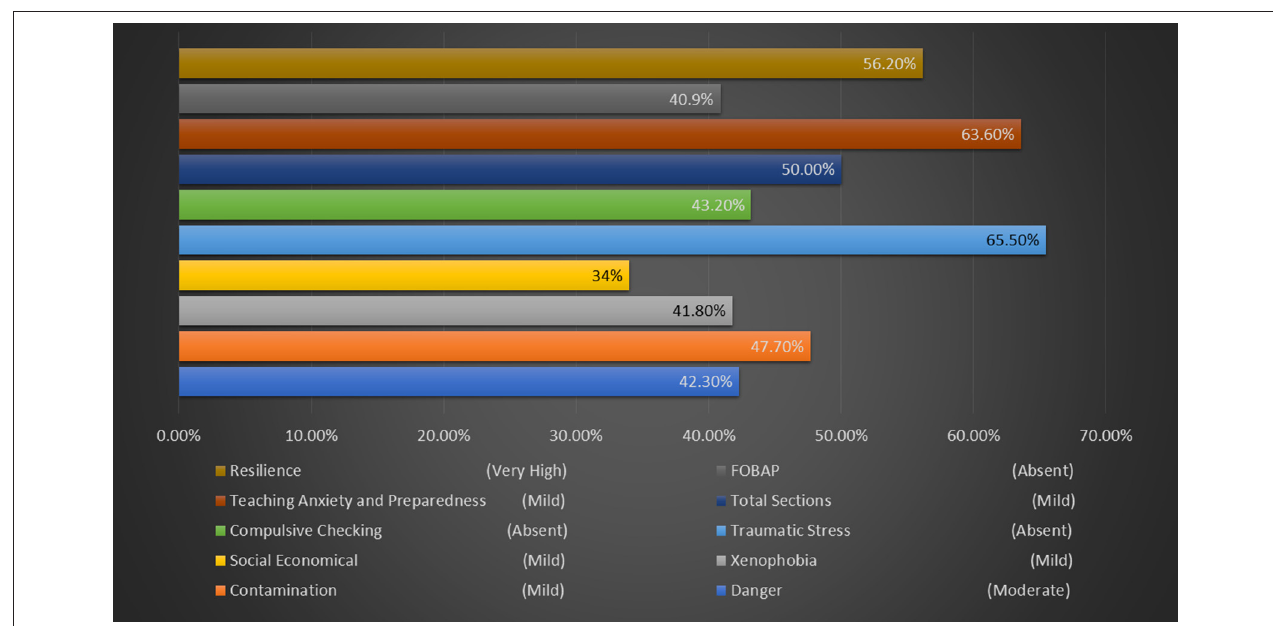
FIGURE 2 | Most representative COVID-related stress frequency (shown as percentage) for the ACSS, Teaching Anxiety and Preparedness, and Resilience for Academic